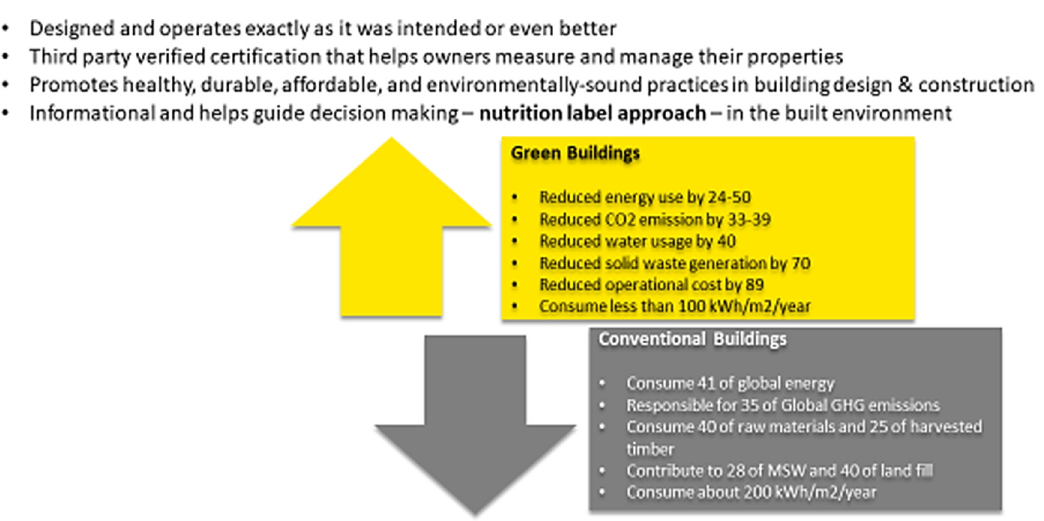
Fig. 5. Major achievements and approaches in transforming into a green economy.